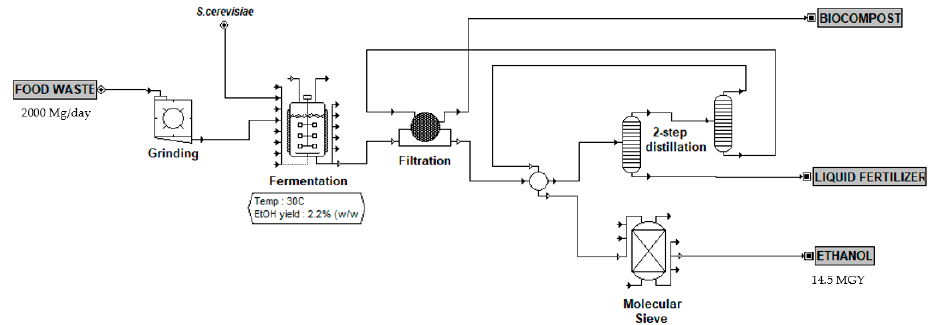
Figure 3. Process flow diagram of the scenario A FW fermentation process without enzymes and a 2-step distillation system.